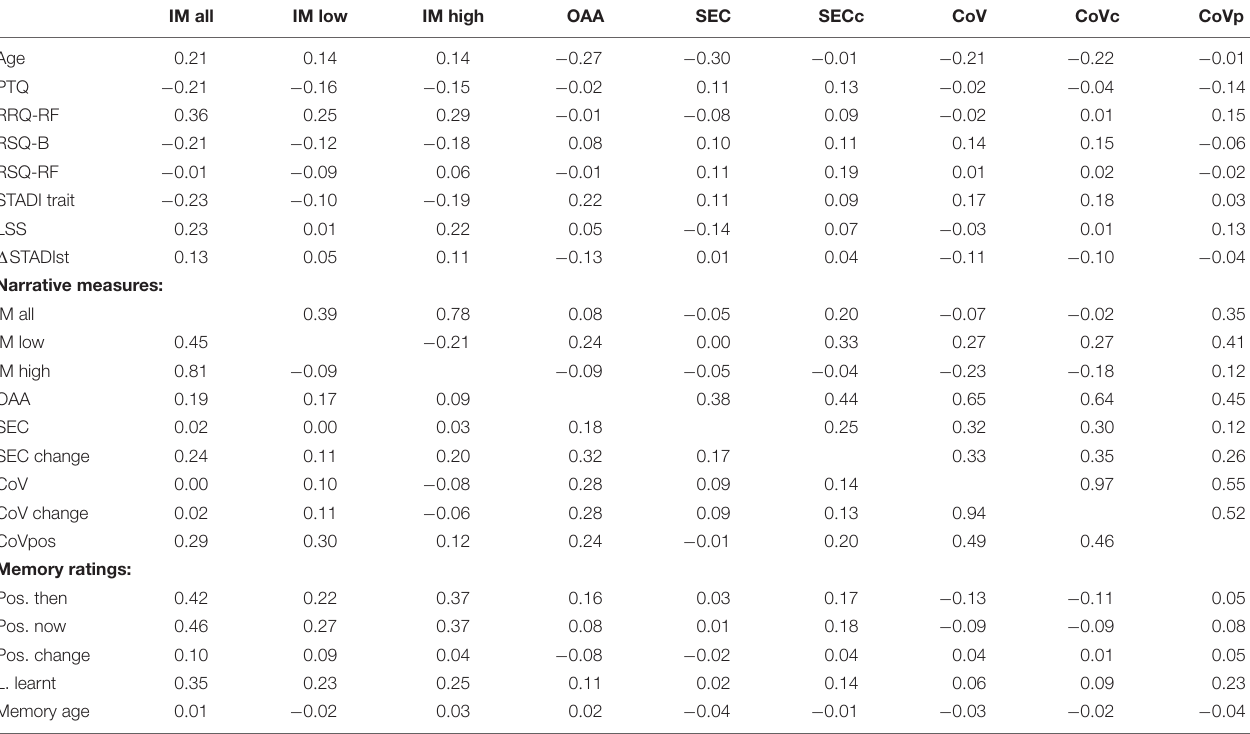
TABLE 3 | Correlations between narrative measures and questionnaires (averaged across narratives in upper rectangle and upper right triangle, within narratives in lower left triangle and lower rectangle). IM